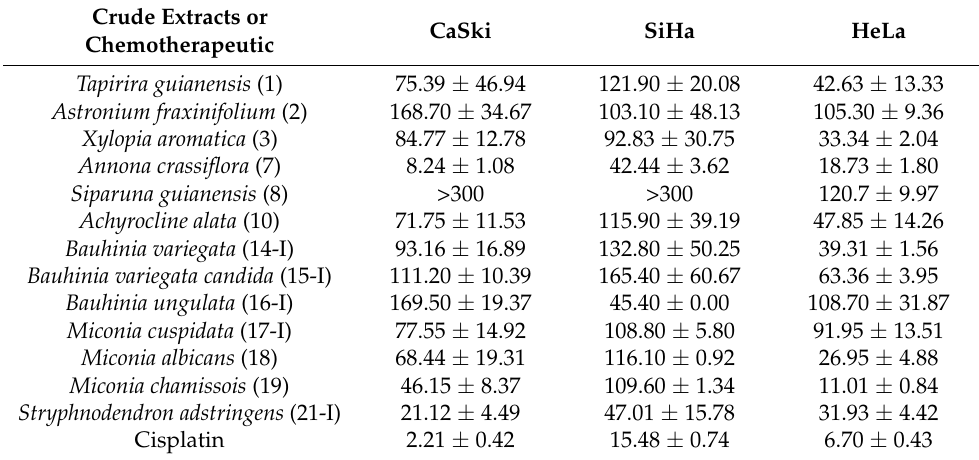
Figure 1. Effect of different natural crude extracts on viability of cervical cancer cell lines. Cellular viability was measured at 72 h by MTS assay. The results were expressed as the mean percentage ± SD of viable cells relatively to the DMSO alone (viability considered to be 100%). The half-maximal inhibitory concentration (IC 50 ) concentrations were calculated by nonlinear regression analysis using Graphpad Prism software. Data represent the mean of at least two independent experiments performed in triplicate. Concentrations of crude extracts ranged from 2.5 to 300 µ g/mL. Cisplatin concentrations ranged from 0.12 to 30 µ g/mL. Table 1. IC 50 values ( µ g/mL) 1 of all crude extracts in human cancer cell